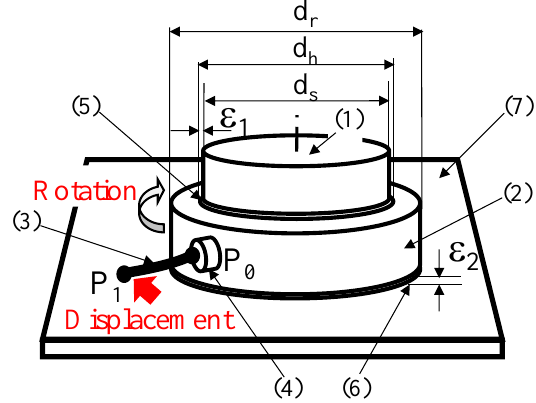
Figure 1. Concept of friction-reduction confirmation mechanism. (1) Shaft (d s ), (2) Rotating ring, (3) Torque wrench, (4) Hand, (5) Circumferential gap, (6) Vertical gap, (7) Base.